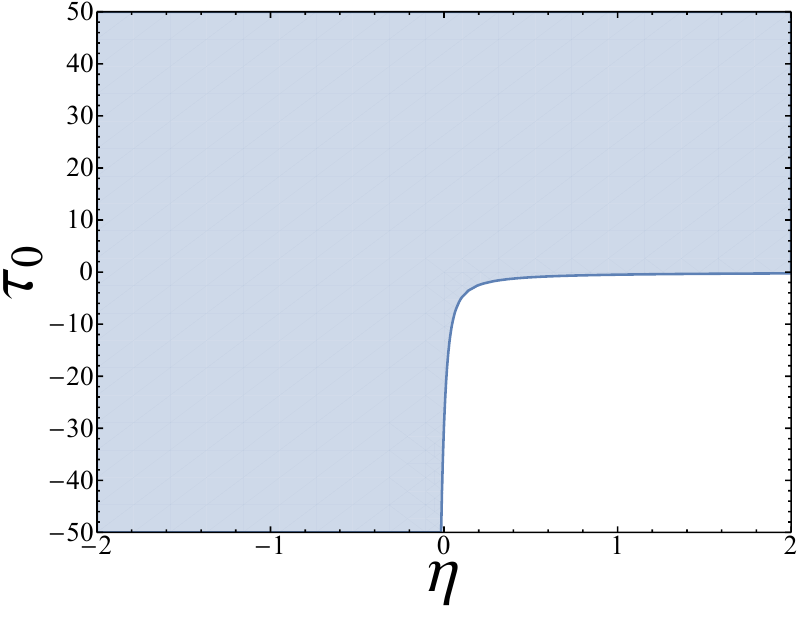
Figure 2 . Region of parameter space which is free of both tachyonic modes and ghosts for x max = 500, (cid:28) (cid:25) (cid:21) 0. The blue region indicates physically allowable points in parameter space, while the unshaded region contains either tachyonic KK modes or ghost-like